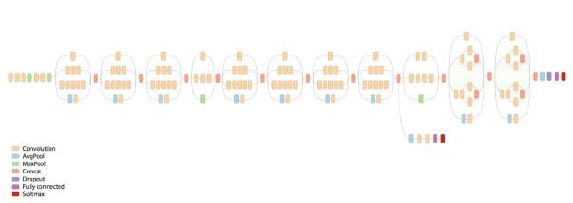
Figure 4. Structure of the convolutional neural network in Google